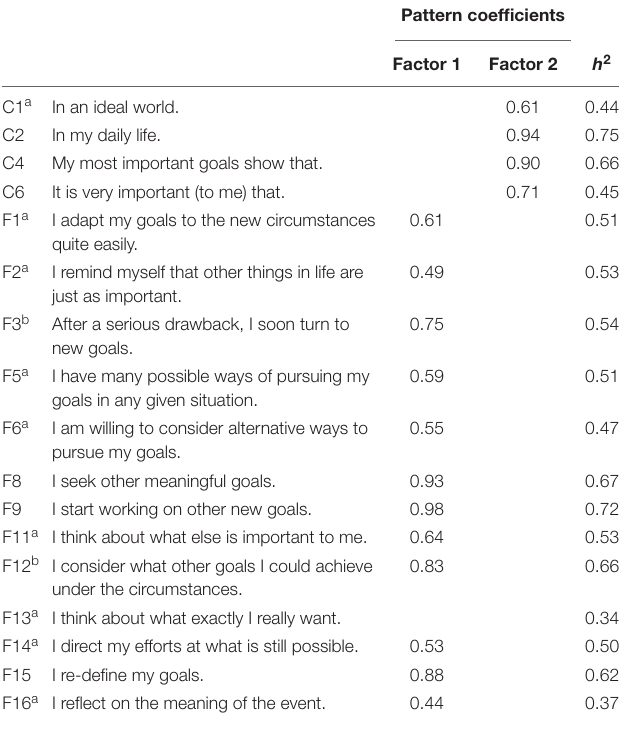
TABLE 2 | Study 1: Pattern matrix from exploratory factor analysis.